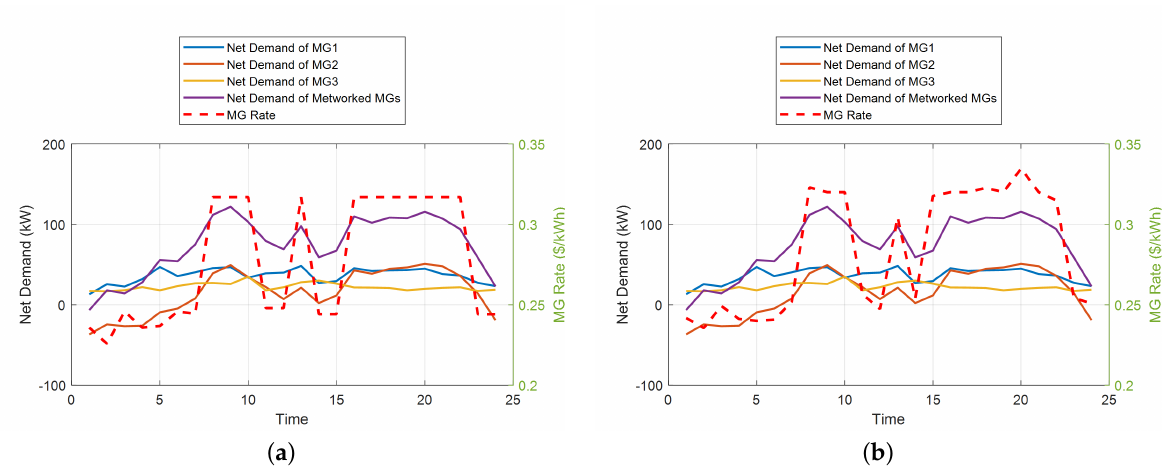
Figure 10. Converged price signal and net demand of networked microgrids by different distributed methods in islanded mode. ( a ) ADMM-based distributed optimization. ( b ) MILP-based